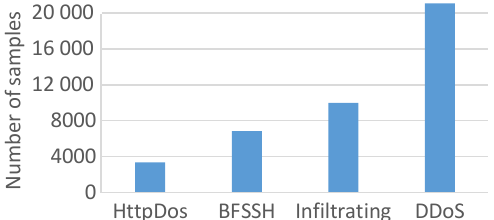
Fig. 8 Number of samples of different intrusive attacks for ISCX2012 dataset.